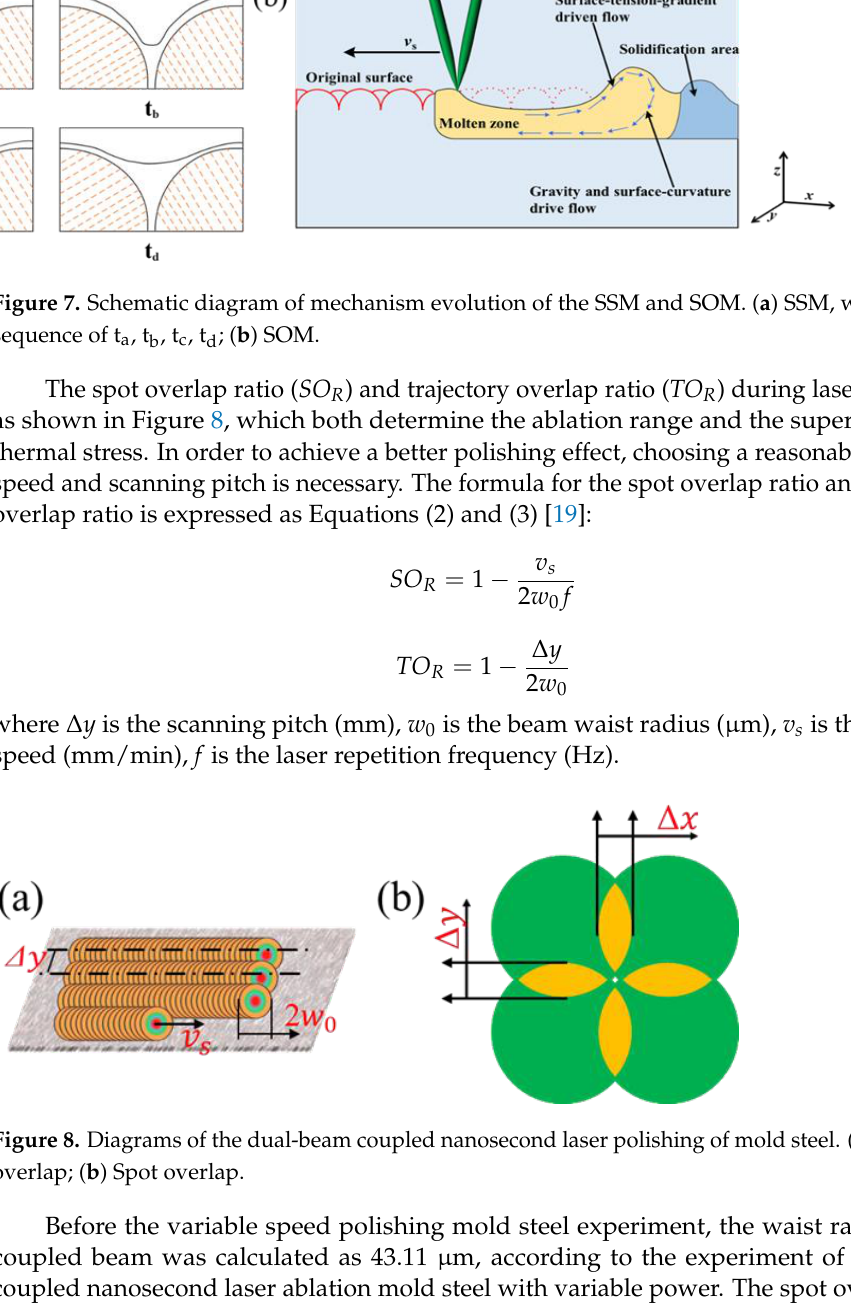
Figure 6. Variations of the total fluence with laser scanning speed.